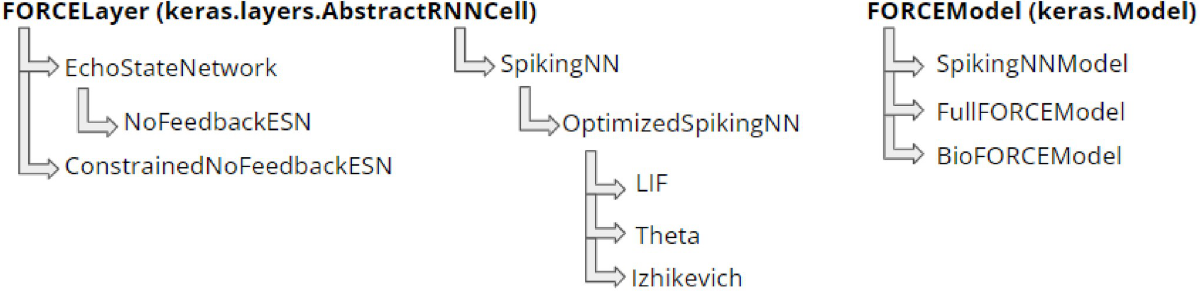
Fig 3. API inheritance